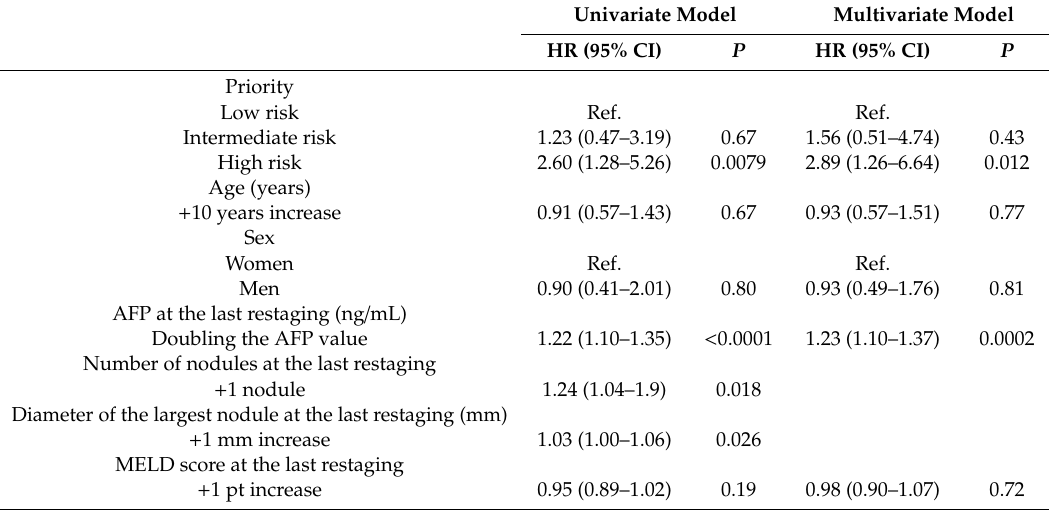
Table 2. Association between patient or tumor characteristics and the risk of HCC recurrence after LT. (N = 330). Hazard ratios estimated using Fine and Gray proportional hazards models, considering death w/o HCC as first event as a competitive event.